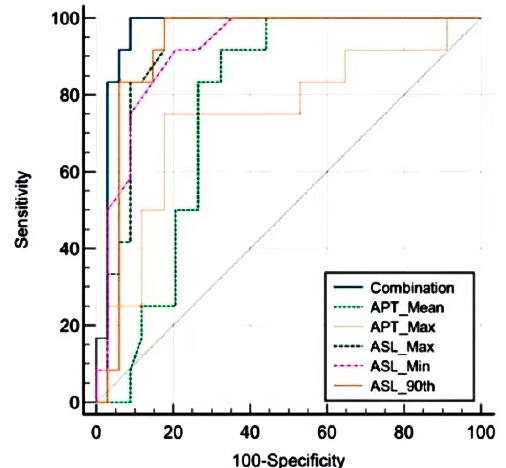
Figure 3. ROC analysis of APT, ASL, and their combination for predicting prognosis.